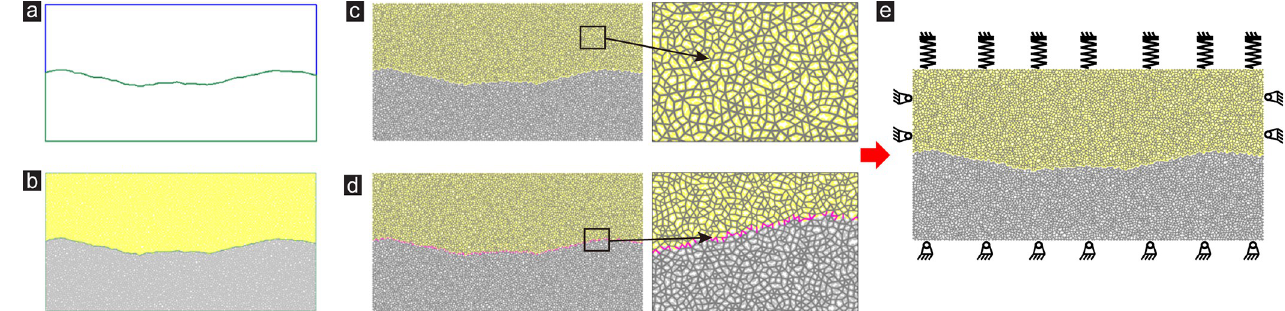
Fig 1. Setup of particle flow model of rock joints under CNS conditions: (a) Initial shear box assembly, (b) Generation of particles, (c) Apply the Parallel Bond Model, (d) Assignment Smooth Joint Model, (e) Application of CNS conditions.